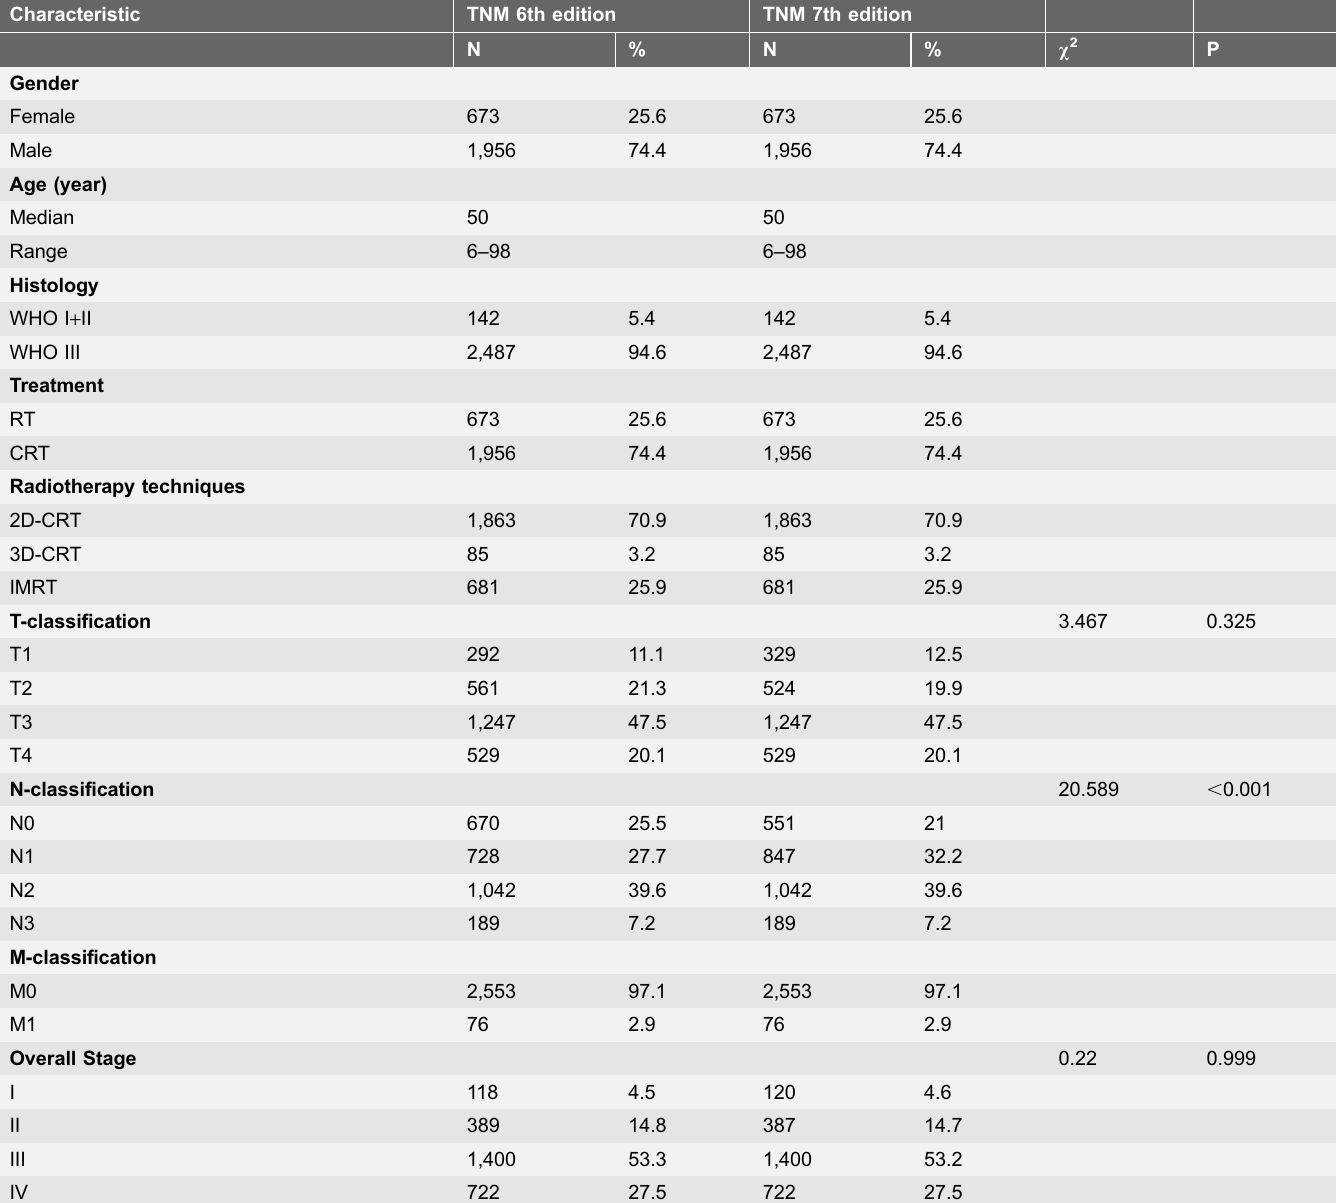
Table 1. Distribution and characteristics of 2,629 patients with nasopharyngeal carcinoma.